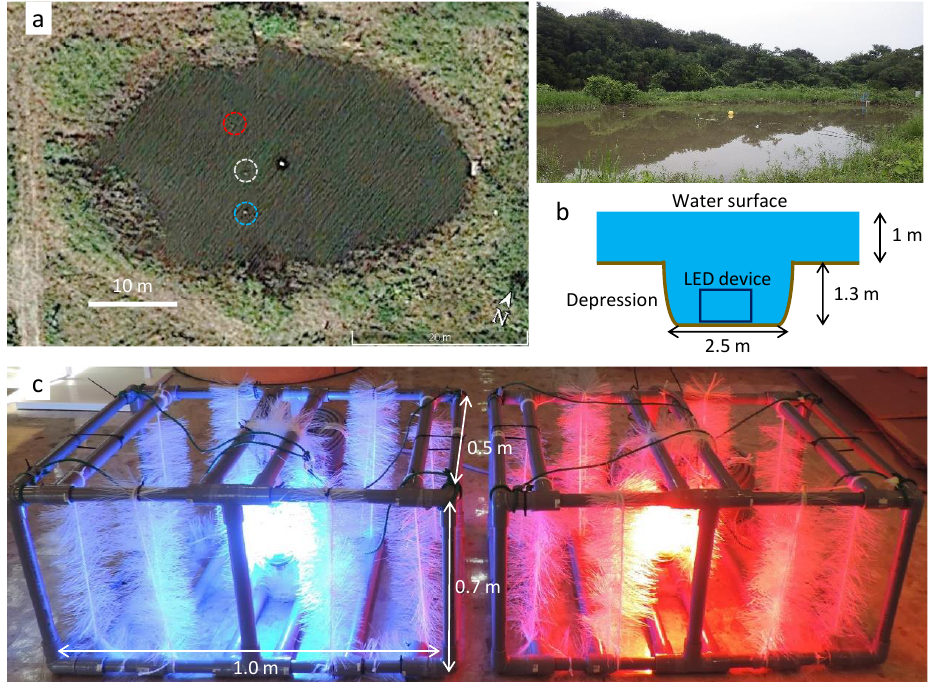
Figure 1. Overview of the experimental pond and the location of three depressions ( a ), vertical view of the depressions ( b ), and LED devices (blue and red) ( c ).